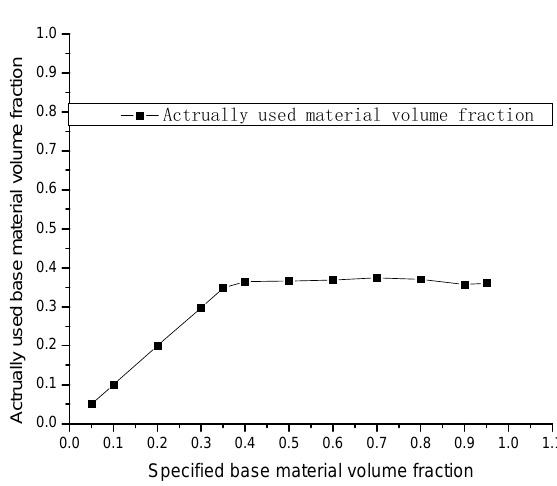
Fig. 4. Trend of actually used material volume with increas- ing of specified material volume fraction